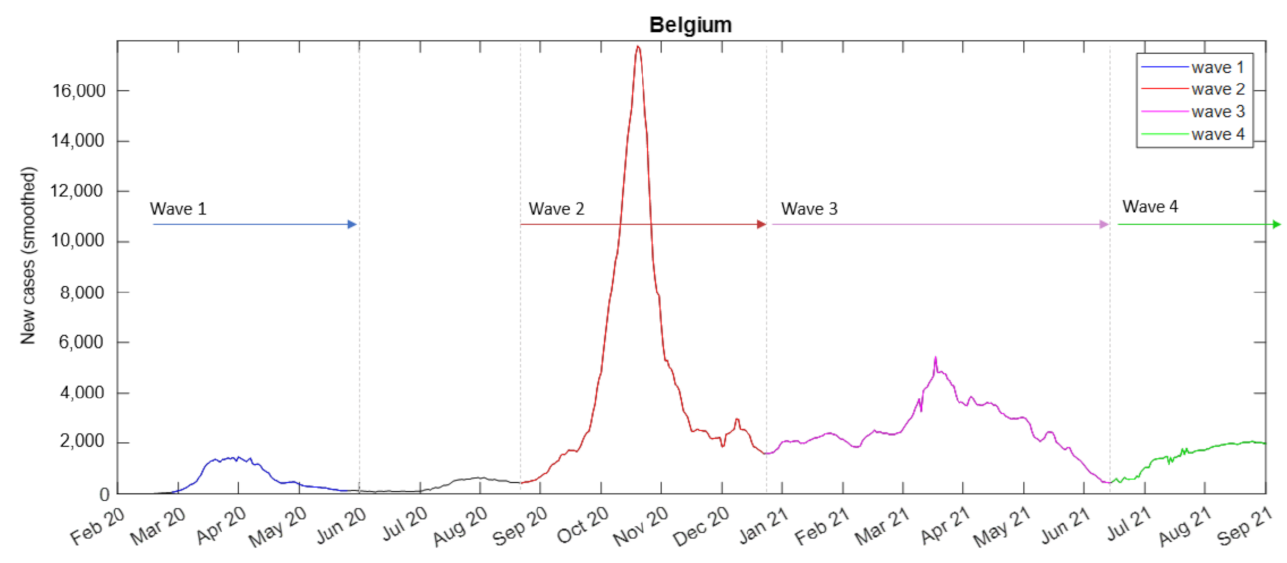
Figure 1. COVID-19 waves for